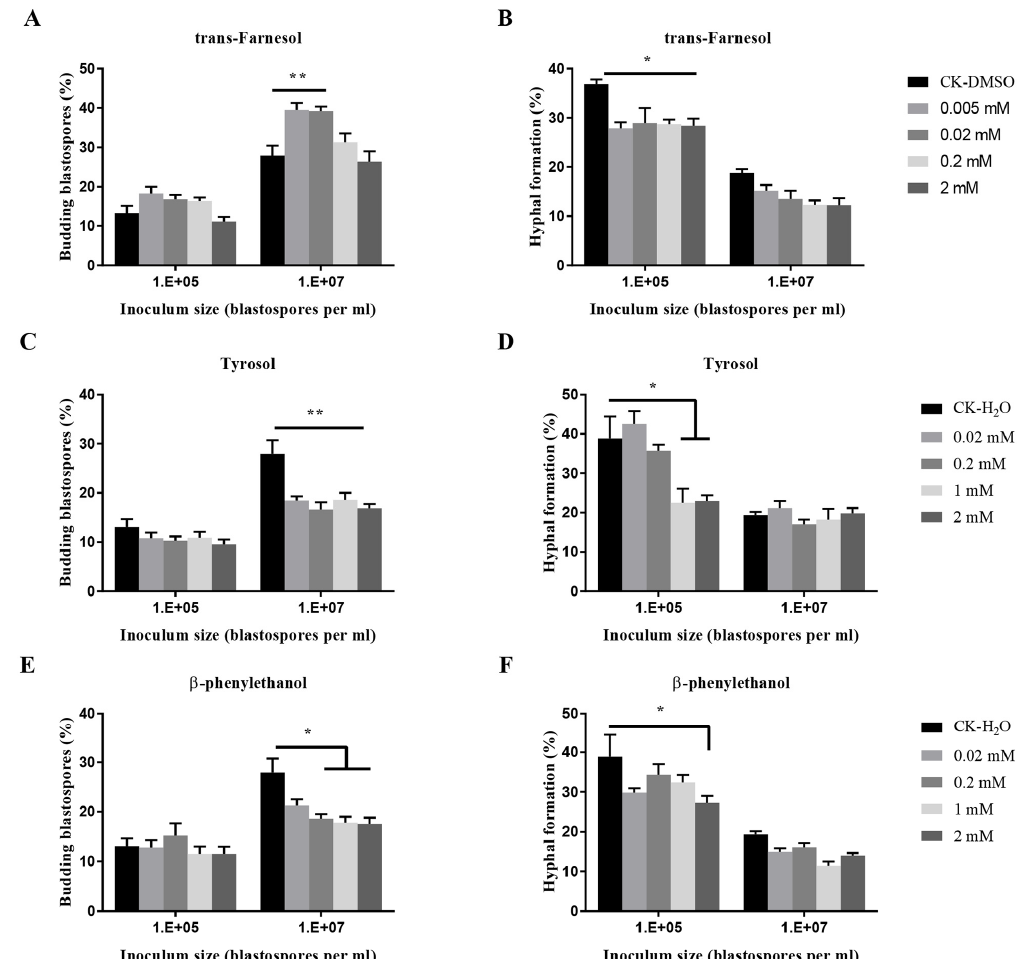
Figure 6. Effects of quorum sensing molecules (QSMs) on budding growth ( A,C,E ) and hyphal Figure 6. E ff ects of quorum sensing molecules (QSMs) on budding growth ( A , C , E ) and hyphal formation ( B,D,F ) of O. sinensis in liquid PM medium 8 days after inoculation. p < 0.05 (*), p < 0.01 (**) formation ( B , D , F ) of O. sinensis in liquid PM medium 8 days after inoculation. p < 0.05 (*) and and p < 0.001 (***). p < 0.01